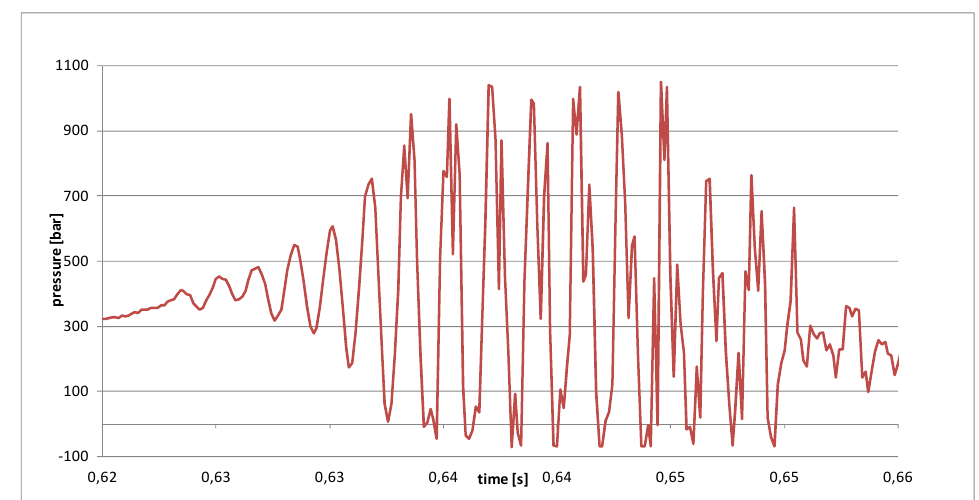
Figure 5. The resulting course of maximum fluid pressure in the sub-piston space.